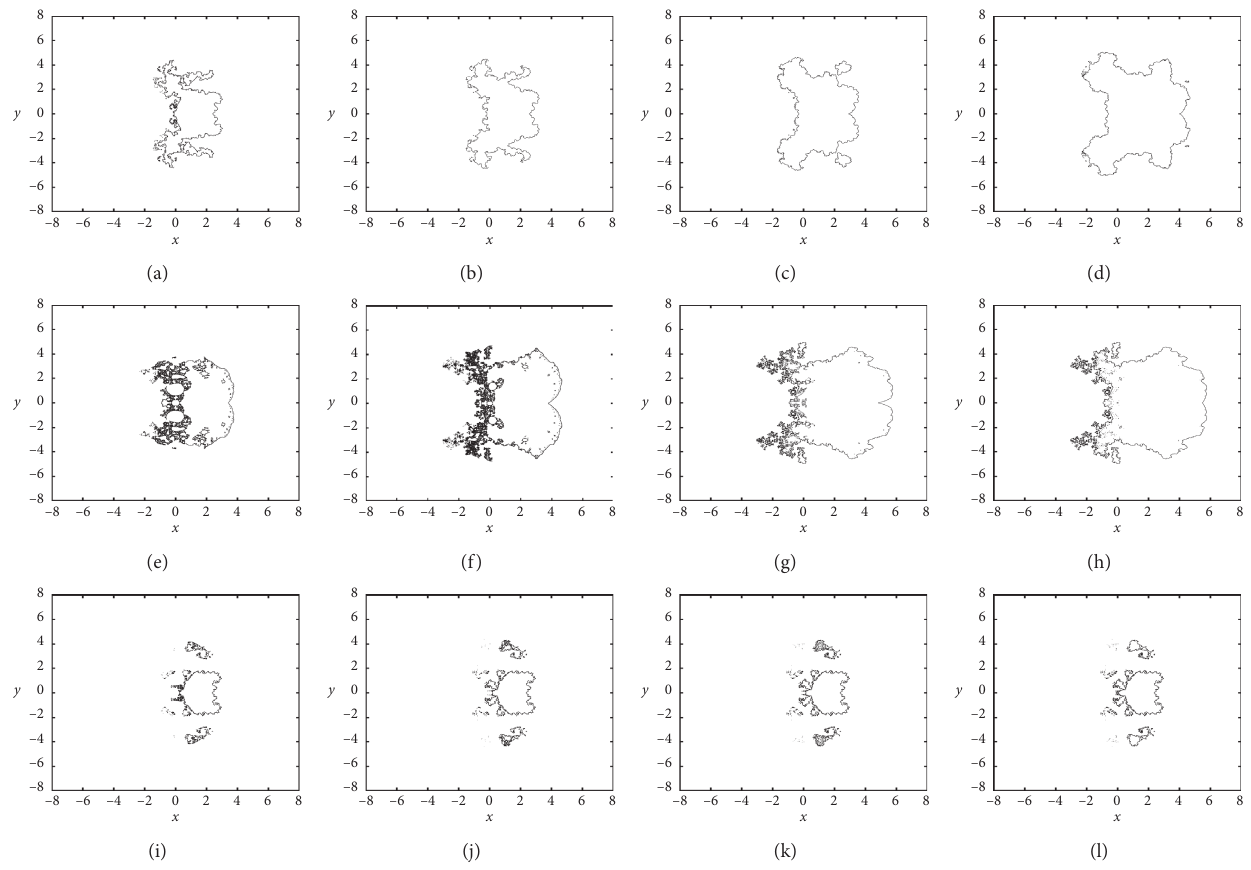
Figure 4: Synchronization of Julia sets of (15) and (23) with different values of ] , μ , and p . (a) t � 0 . 08, (b) t � 0 . 3, (c) t � 0 . 6, (d) t � 0 . 9, (e) t � 0 . 01, (f) t � 0 . 3, (g) t � 0 . 7, (h) t � 0 . 9, (i) t � 0 . 001, (j) t � 0 . 3, (k) t � 0 . 5, and (l) t � 0 .